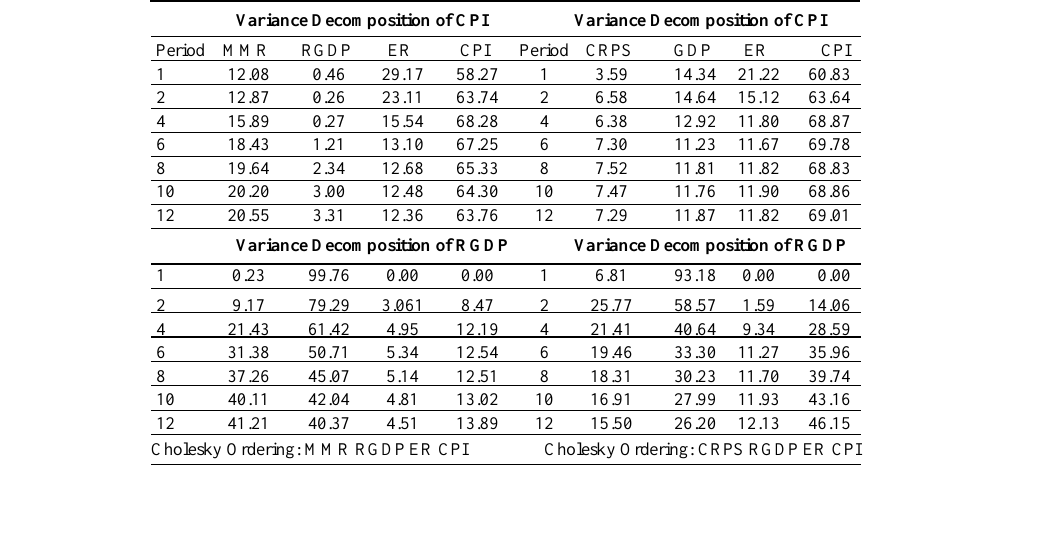
Variance Decomposition of CPI and RGDP